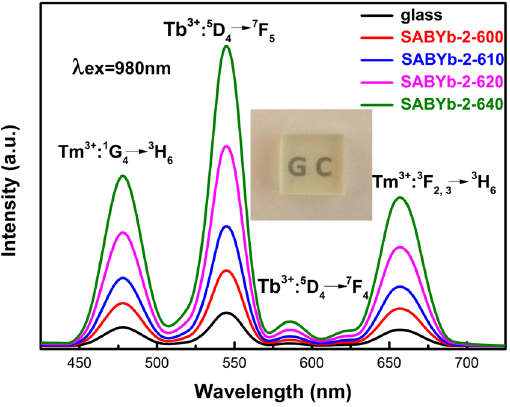
Figure 3. The UEC emission spectra of SABYb-2 glass and glass-ceramics, which were heat-treated at 600 °C, 610 °C, 620 °C and 640 °C for 2 h.